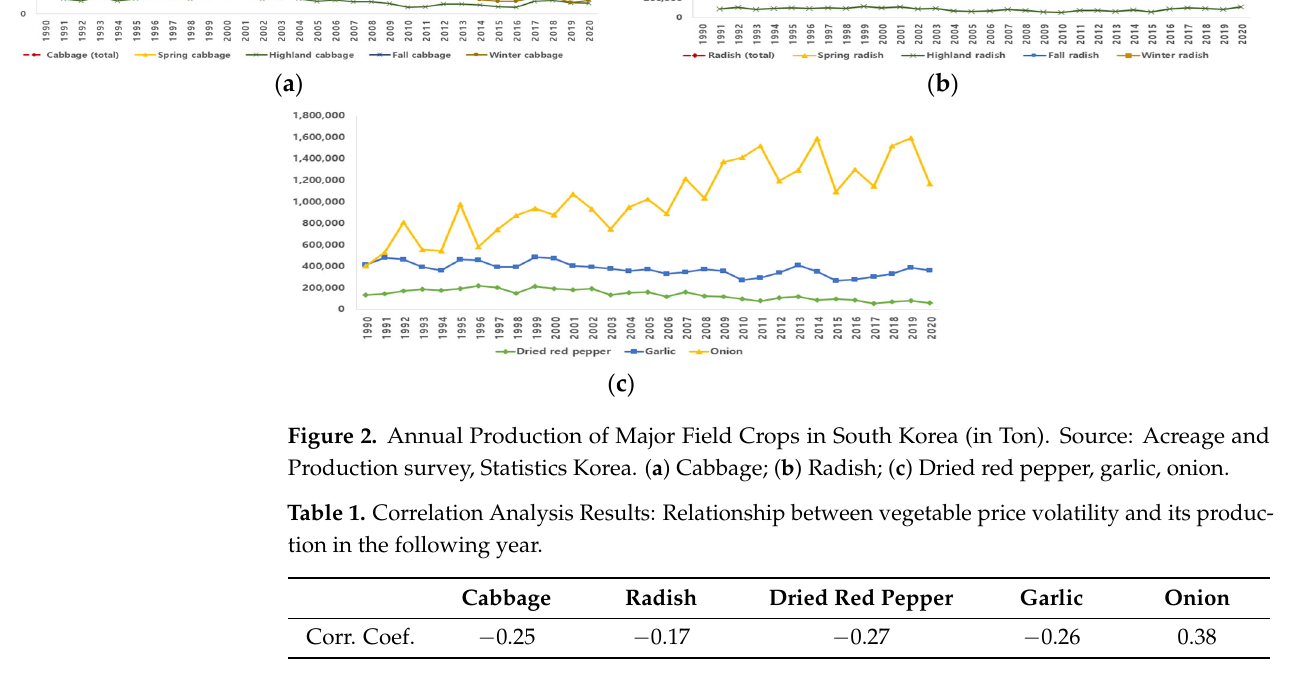
Table 1. Correlation Analysis Results: Relationship between vegetable price volatility and its pro ‐ duction in the following year. Cabbage Radish Dried Red Pepper Garlic Onion Corr. Coef. − 0.25 − 0.17 − 0.27 − 0.26 0.38